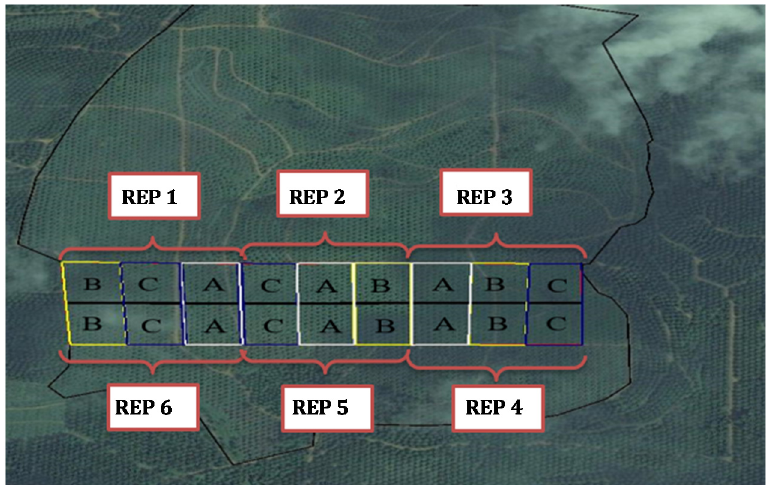
Figure 3. Plots of the study area, showing the treatments block (A: Good Agronomic Practice, B: Standard Practice, and C: Sub-Standard) and the leaft sampling method with 18 plots and six replications (REP1 to REP6).